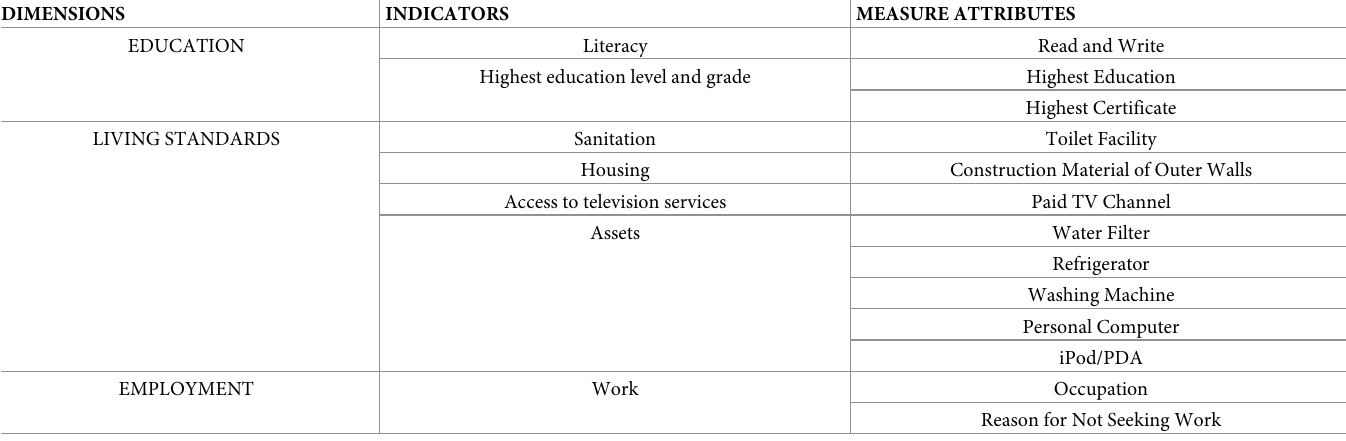
Table 11. Dimensions, indicators and measure attributes identified from the B40 clustering